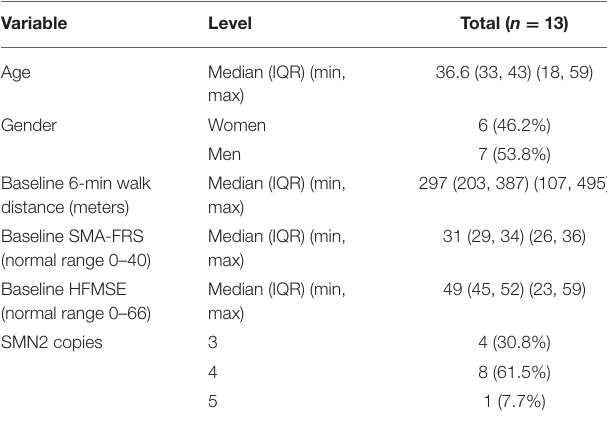
TABLE 1 | Demographics and baseline